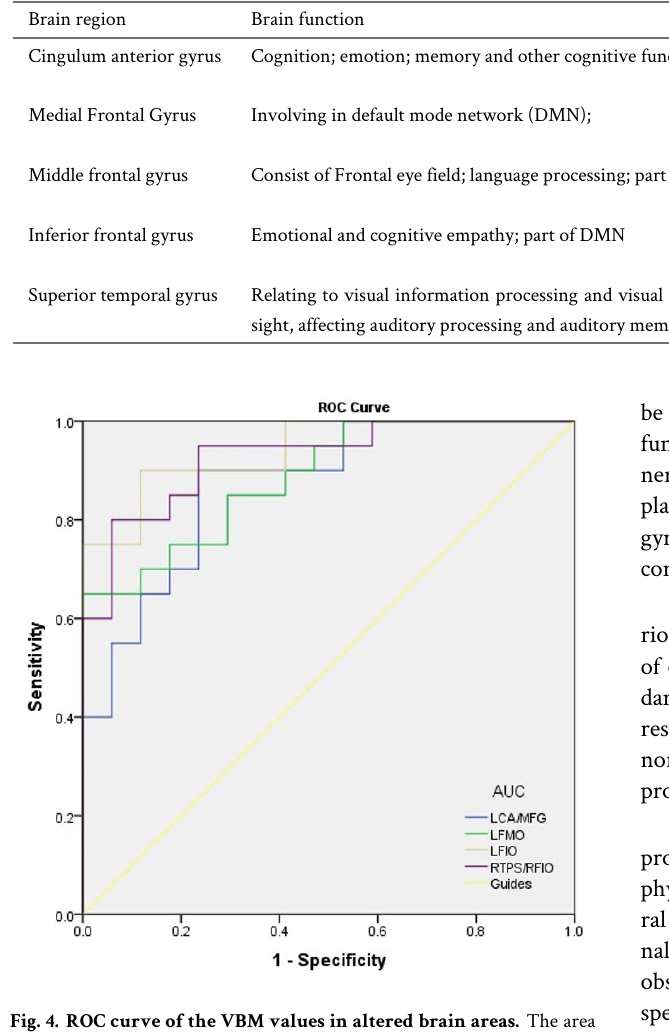
Table 4. Changed FCD values in brain regions and its potential impact.